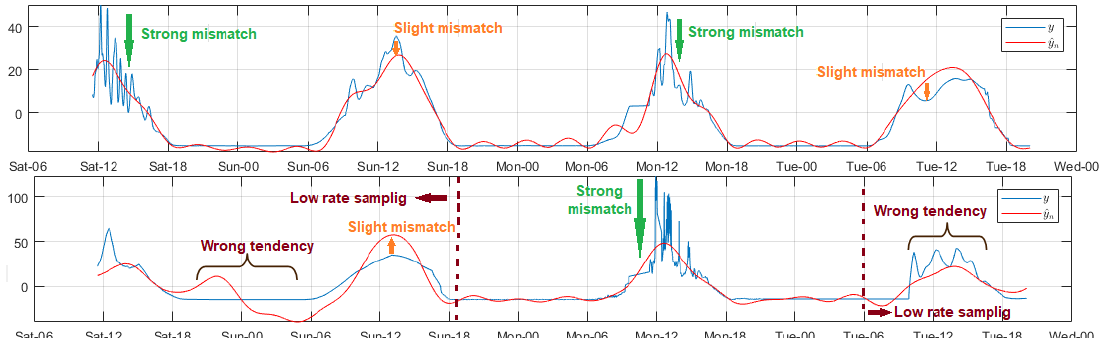
Figure 7. Representative modeled signals of UV radiation: ( Top ) Node 3 ZigBee network with Reg = 110; and ( Bottom ) Node 3 of WiFi network with Reg =